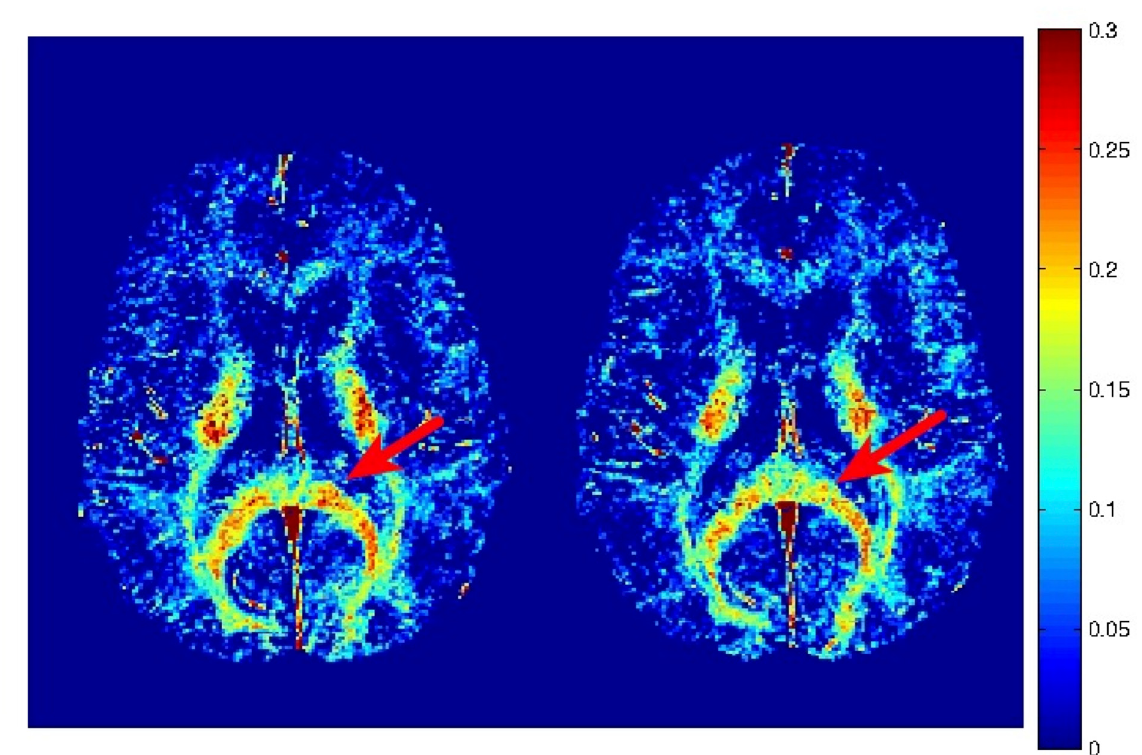
Fig 1. Representative myelin water fraction maps. Myelin water fraction maps from a concussed athlete at baseline (left) and two weeks post-injury (right). Myelin water fraction is measured as the T2 signal from 0 – 40 ms divided by the total T2 signal. A region of the corpus callosum with a visible reduction in MWF post-injury is highlighted by the red arrow.